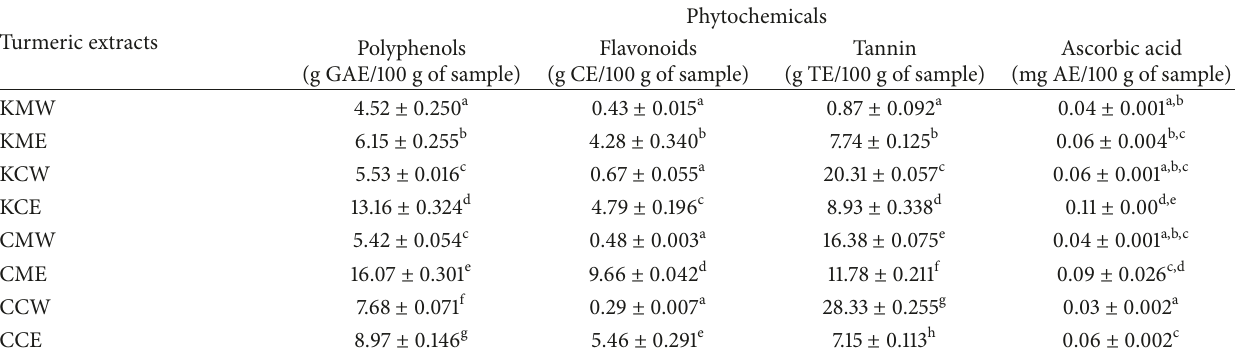
Table 3: Concentrations of total polyphenols, flavonoids, tannins, and ascorbic acid of the turmeric varieties (mura and chora) collected from Khulna and Chittagong